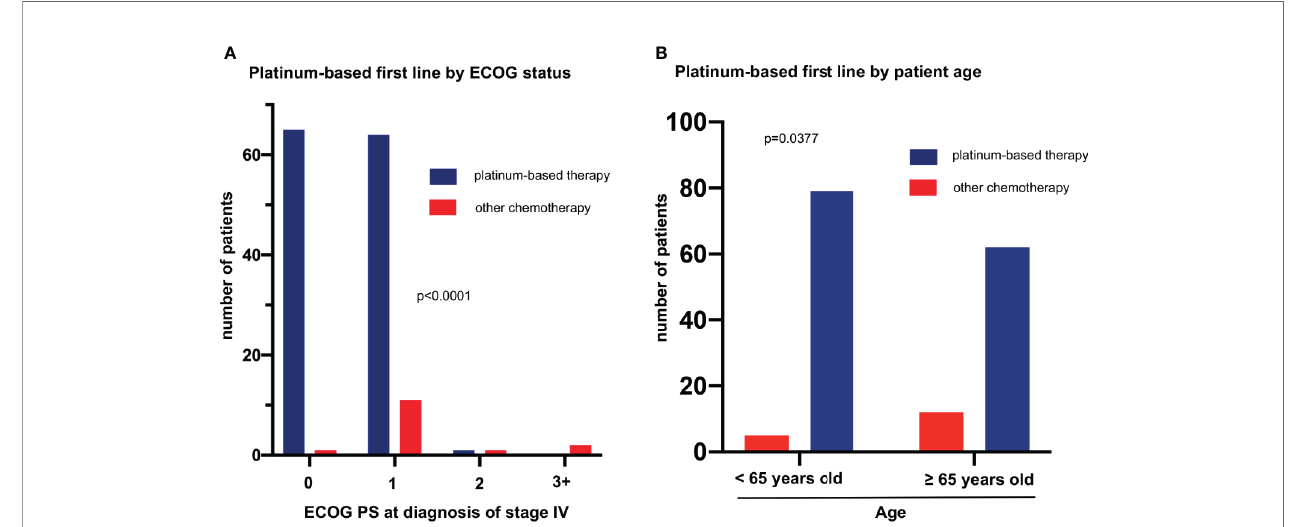
FIGURE 3 | Factors associated with platinum-based fi rst line in metastatic LCNEC. (A) The rate of platinum-based fi rst-line treatment was 99% (65/66), 85% (64/ 75), 50% (1/2), and 0% (0/2) among patients with ECOG performance status (PS) 0, 1, 2, and ≥ 3 (chi-square p = 0.00004). (B) The rate of platinum-based fi rst line treatment was 94% (79/84) among patients younger vs. 84% (141/158) among patients older than 65 years (median age, Table 1 , chi-square p =